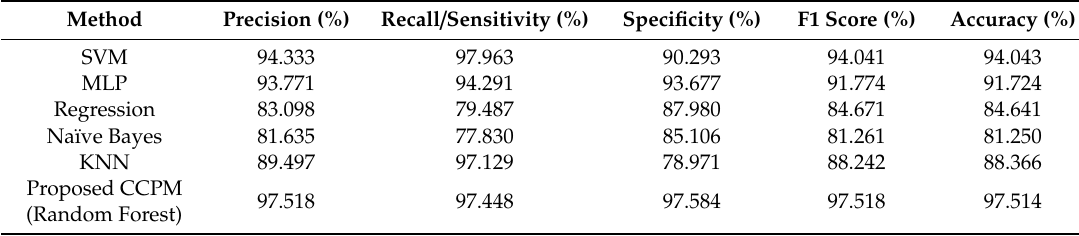
Table 20. Performance evaluation results based on iForest and SMOTE for